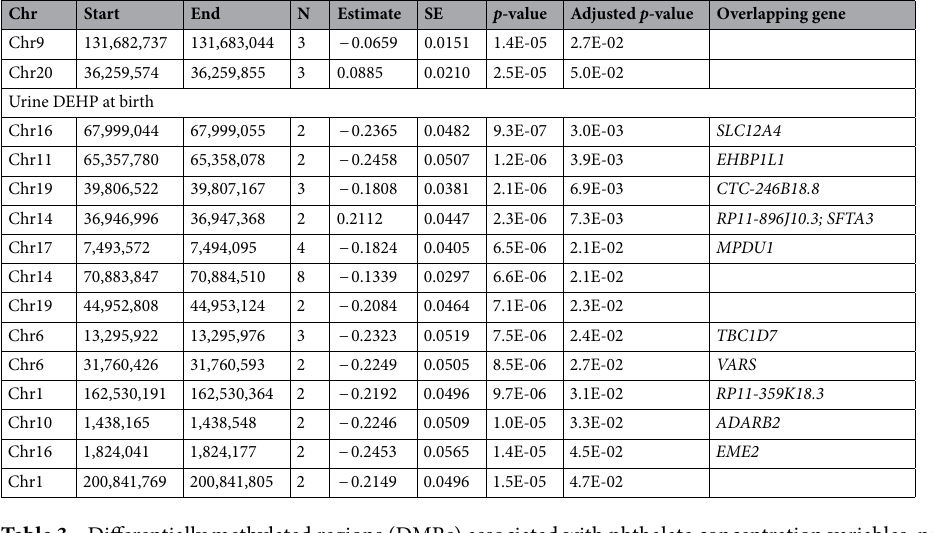
Table 3. Differentially methylated regions (DMRs) associated with phthalate concentration variables. n: number of CpGs; SE: standard error.